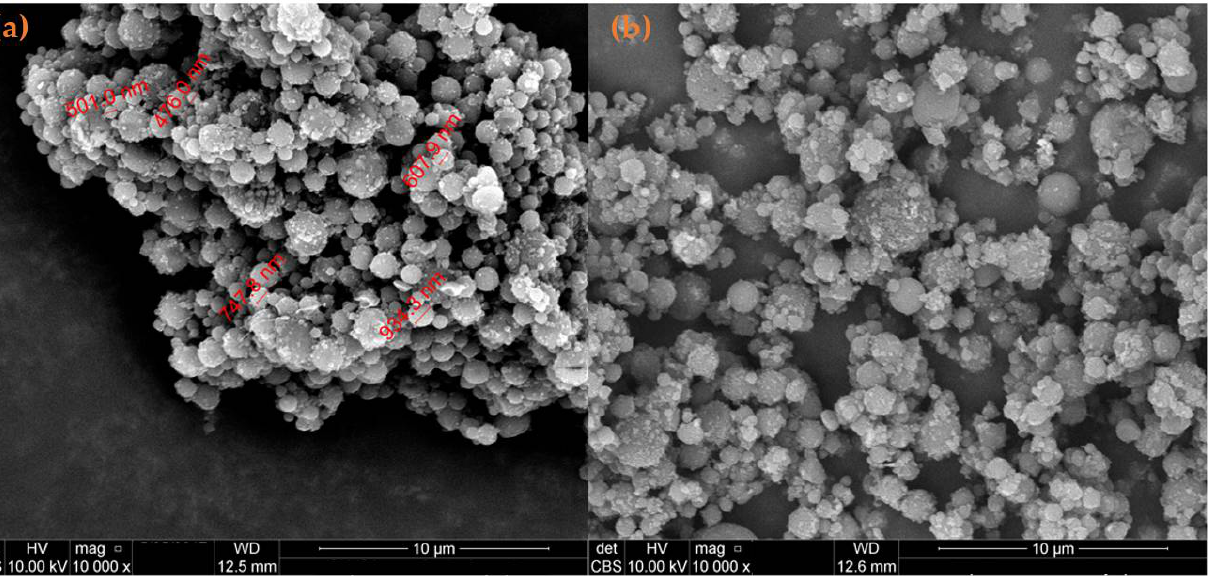
Figure 8. SEM images of ( a ) PLGA-CS-Fe 3 O 4 @NEO and ( b ) PLGA-CS-Fe 3 O 4 @STR composite spheres.